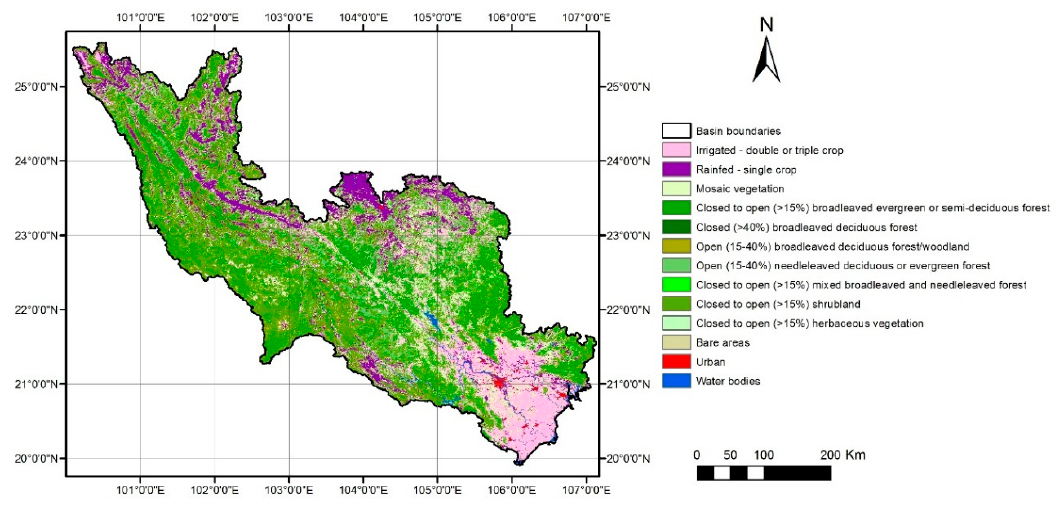
Figure 3. LULC map of the Red River Basin.